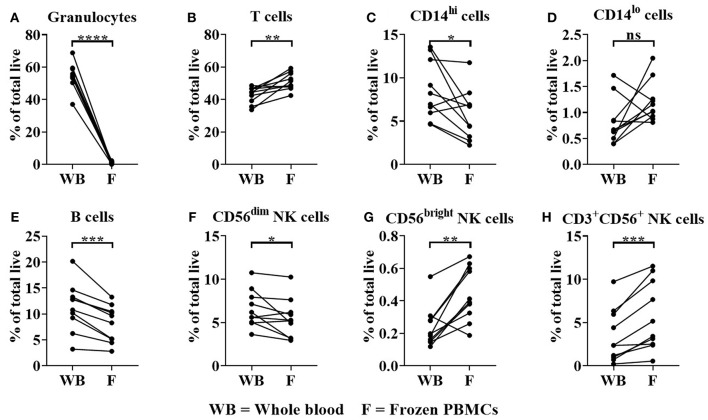
Immune cell subset frequencies in donor matched whole blood (WB) and frozen (F) PBMC samples. Immune cell subset frequencies were quantified in donor matched whole blood, fresh and frozen PBMCs using flow cytometry. Immune cell frequencies were quantified as % of total live/single cells (A) % Granulocytes, (B) T cells, (C) CD14hi monocytes, (D) CD14lo monocytes, (E) B cells, (F) CD3−CD56dim, (G) CD3−CD56bright, and (H) CD3+CD56+ NK cells of total live/single cells. Each point represents a donor, bars represent group means, (n = 10). *p < 0.05, **p < 0.01 ***p < 0.001 and ****p < 0.0001 and ns = non-significant.